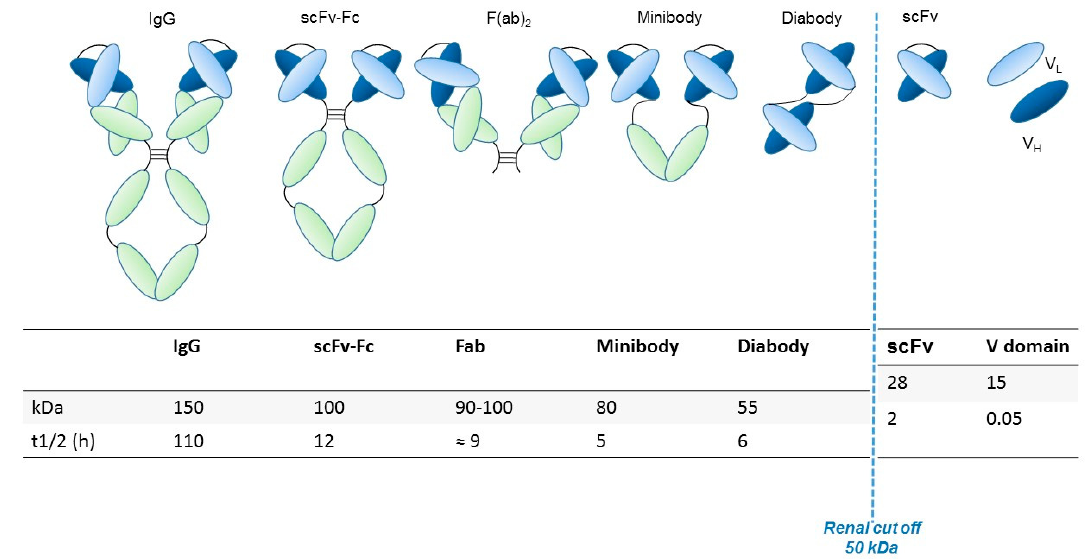
Figure 1. Engineered antibody formats. Different antibody formats are reported in the figure, showing their different size compared to intact IgG. Ig, Immunoglobulin; scFv, single-chain variable fragment; V domain, variable domain. In the figure, the size (KDa) of each different antibody format and their half-lives (t 1/2 , i.e., time needed to eliminate half of the molecule from circulation) are also reported.